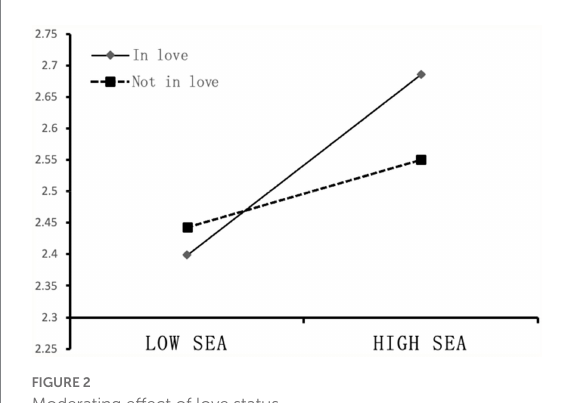
TABLE 5 Moderated mediating effect analysis.